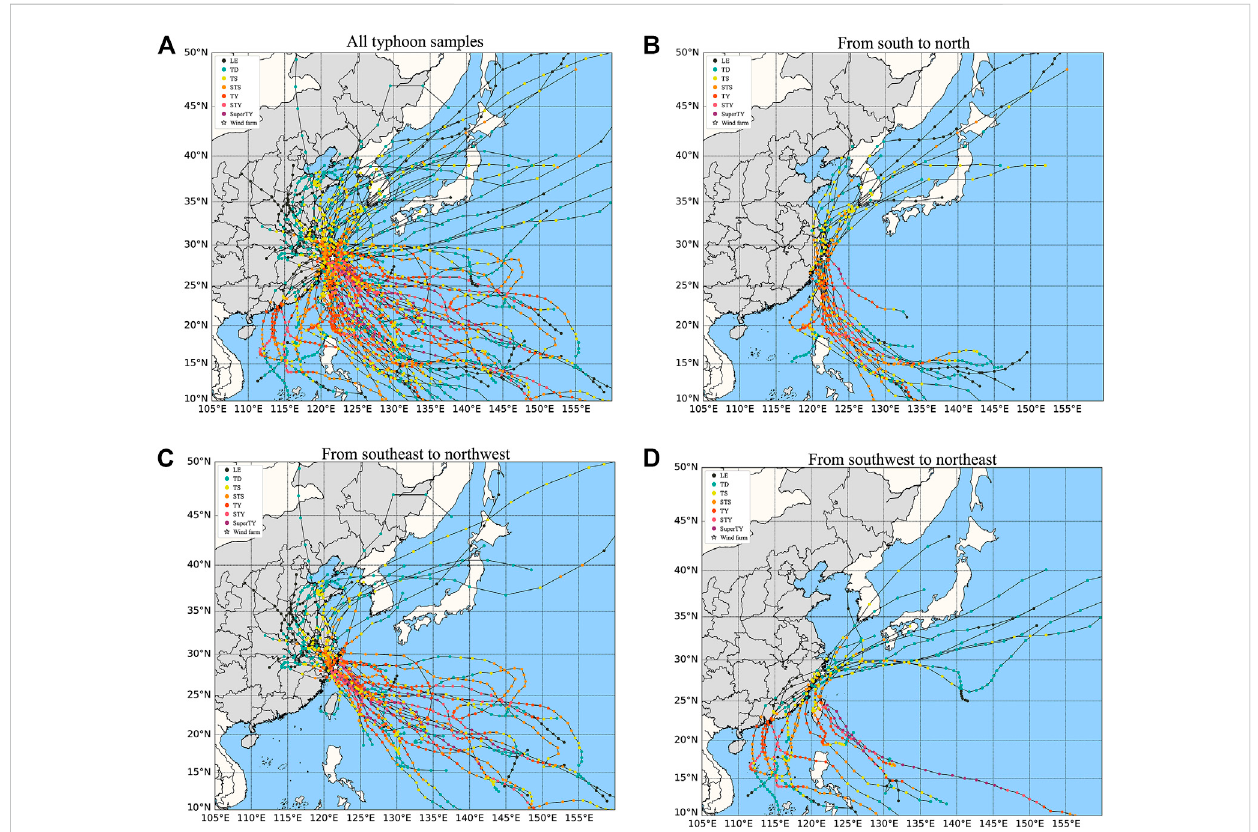
Best-track positions and intensities for (A) all tropical cyclones and those moving (B) northward, (C) northwestward, and (D) northeastward within 150 km of the area of the Donghaitang wind farm during 1949 – 2021. The numbers of tropical cyclones in panels (A) – (B) are 64, 17, 31, and 16, respectively. Different colors represent different intensity levels: black for low eddy (LE: ≤ 10.7 m s − 1 ), green for tropical depression (TD: 10.8 – 17.1 m s − 1 ), yellow for tropical storm (TS: 17.2 – 24.4 m s − 1 ), orange for severe tropical storm (STS: 24.5 – 32.6 m s − 1 ), red for typhoon (TY: 32.7 – 41.4 m s − 1 ), pink for severe typhoon (STY: 41.5 – 50.9 m s − 1 ), and purple for super typhoon (Super TY: ≥ 51 m s − 1 ). The time interval between two adjacent points is 6 h, and the white star marks the location of the Donghaitang wind